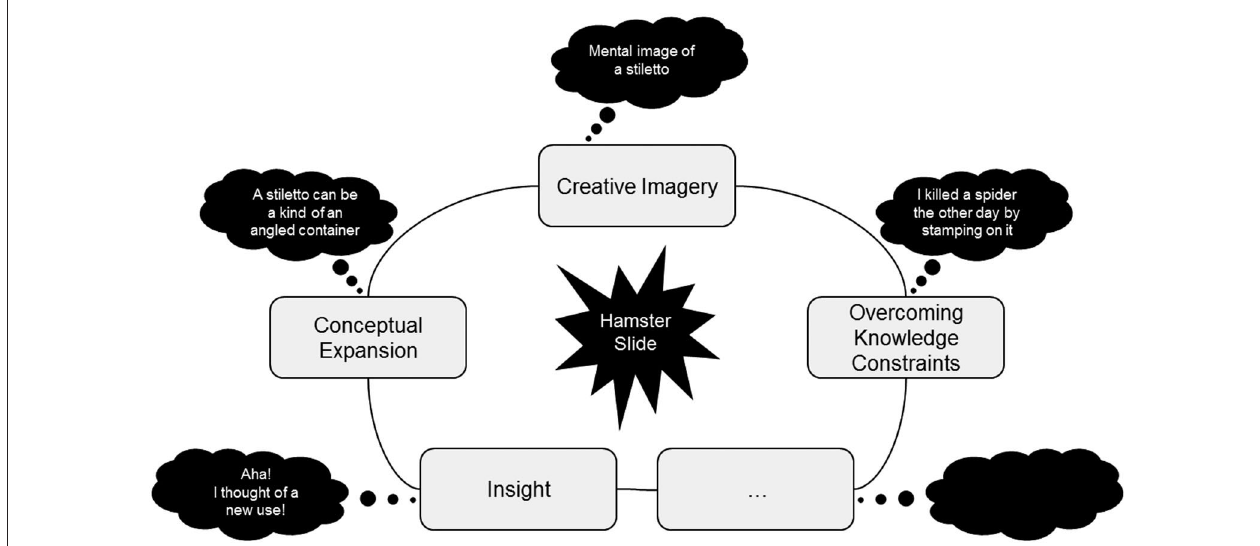
FIGURE 1 | A schematic diagram to highlight four of the several different mental operations that are involved in creative thinking with a hypothetical example of how different aspects of creative cognition work in unison during creative idea generation